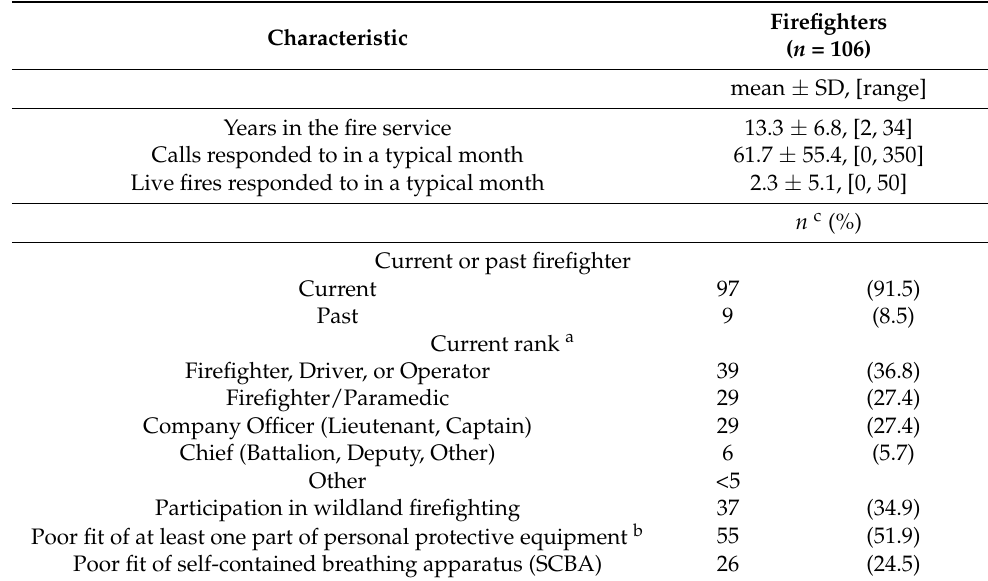
Table 2. Occupational history restricted to female firefighters in our sample ( n =